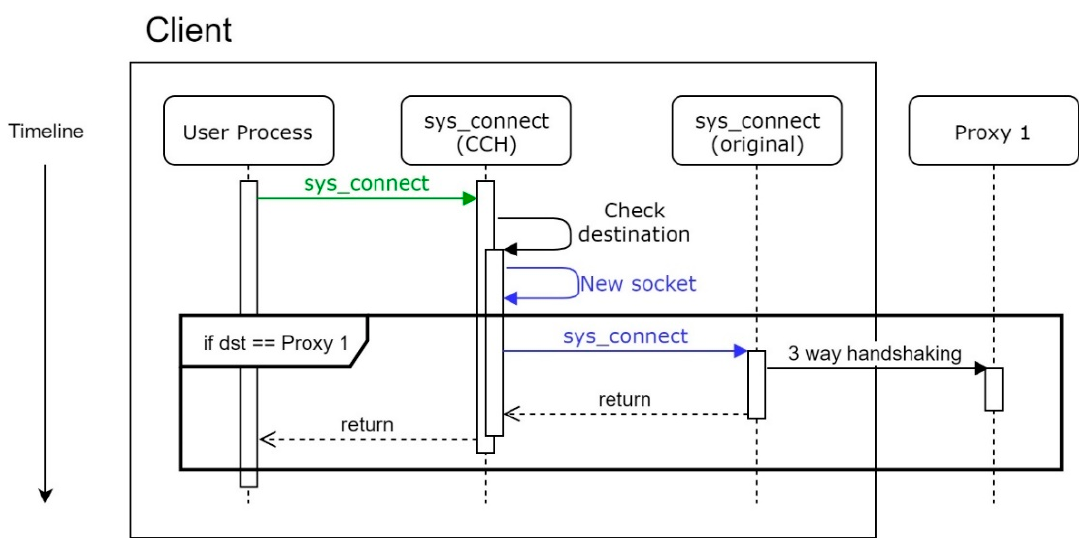
Figure 8. Workflow of CCH when no response.